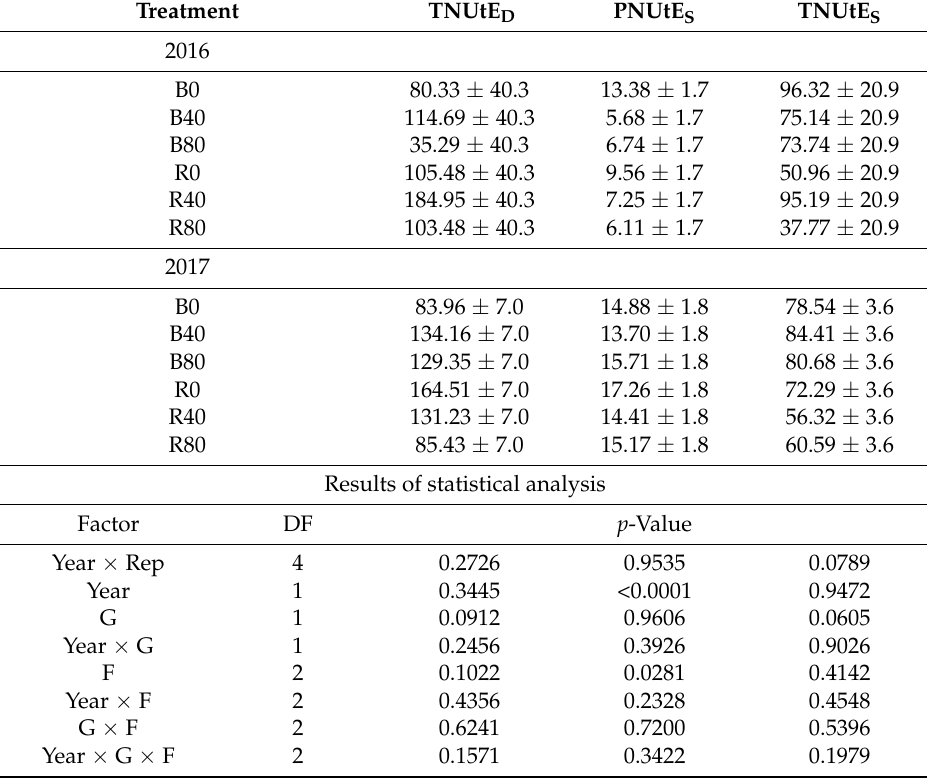
Table 7. Indicator for tuber N utilization efficiency for tuber dry-matter yield (TNUtE D ), total plant N last destructive measurement (161 and 165 DAP) immediately before harvest for the two years (2016 and 2017) of the six treatments (B0, B40, B80, R0, R40, and R80), notated as the mean value ± standard error. Treatment TNUtE